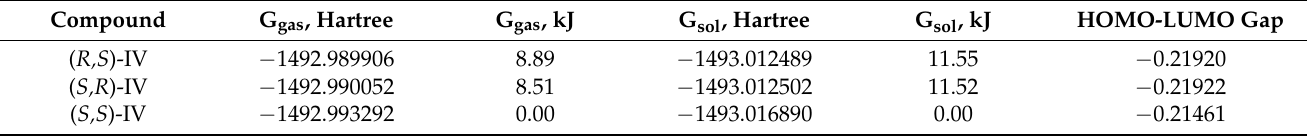
Table 10. Energy characteristics of ( R,S )-, ( S,R )-, and ( S,S )-optical isomers